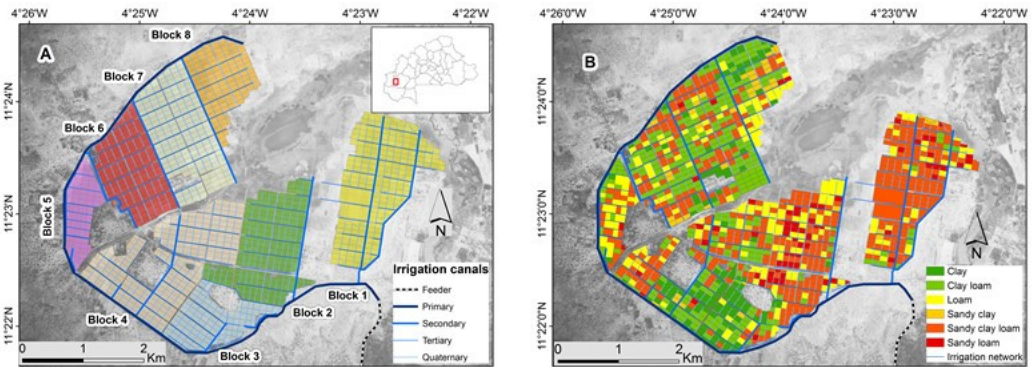
Figure 1. Distribution of irrigation canals and blocks ( A ) and dominant soil types per plot ( B ) at the Kou Valley irrigation scheme, Burkina Faso. Adapted from [29].